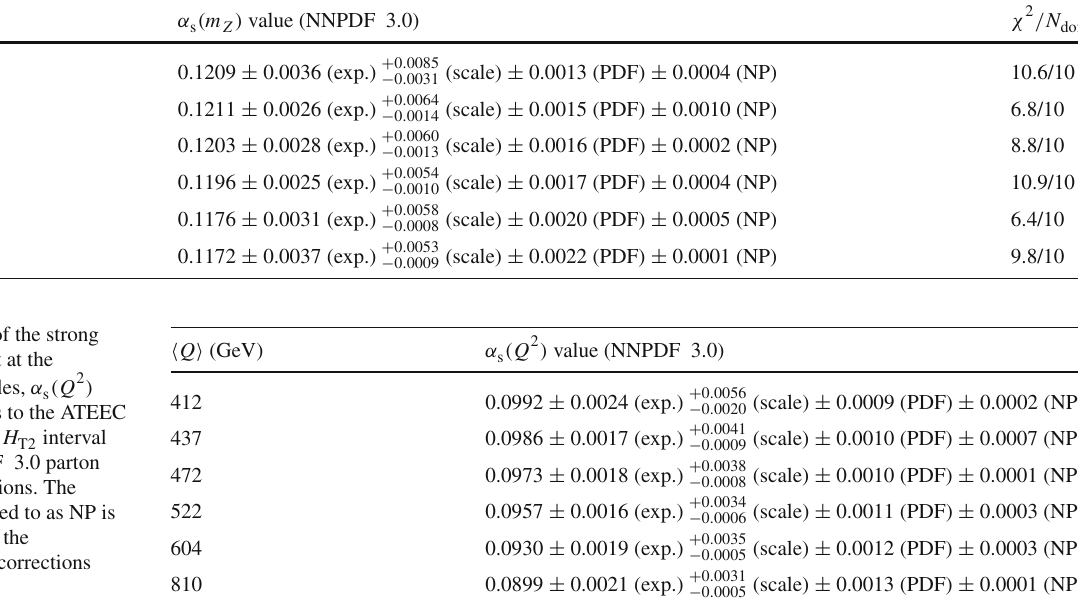
Table 5 Values of the strong coupling constant at the Z boson mass scale, α s ( m Z ) obtained from fits to the ATEEC function for each H T2 interval using the NNPDF 3.0 parton distribution functions. The val- ues of the average scale (cid:4) Q (cid:5) for each energy bin are shown in the first (cid:4) Q (cid:5) (GeV)